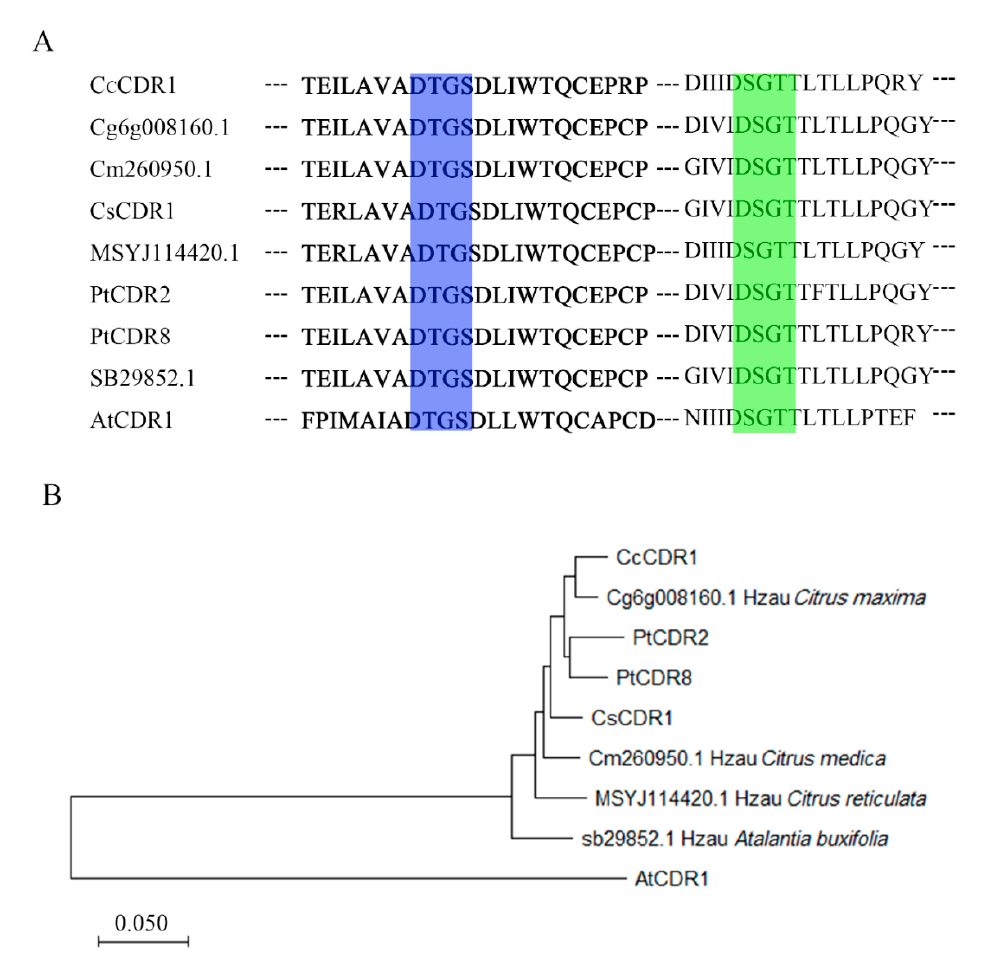
Figure 1. Bioinformatical analysis of PtCDR2 and PtCDR8 with CDR1s from other citrus and Arabidopsis . ( A ) Two conserved catalytic motifs were present in PtCDR2, PtCDR8, and CDR1s from Arabidopsis (AtCDR1), Citrus maxima (Cg6g008160.1), Citrus medica (Cm260950.1), Citrus reticulata (MSYJ114420.1), Atalantia buxifolia (sb29852.1), Citrus sinensis (CsCDR1), and Citrus